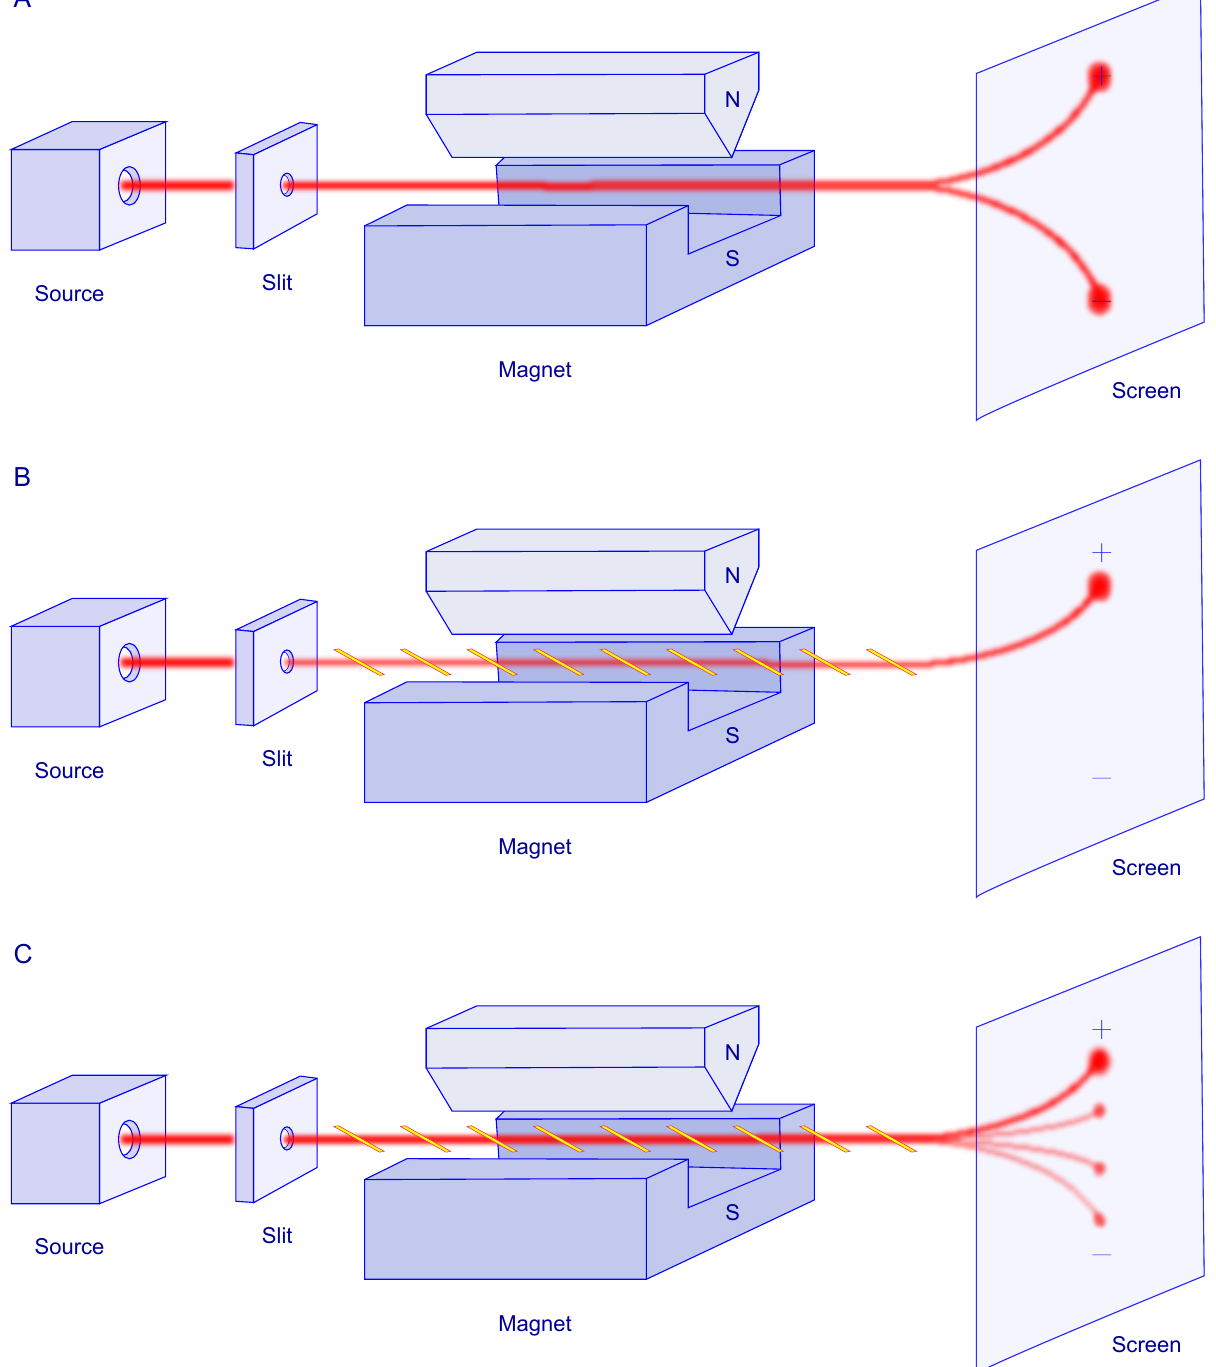
Figure 1: A. The standard Stern-Gerlach measurement setup denoting a projective measurement on a spin- 1 emits a collimated beam of silver atoms directed between the poles of a magnet that produces an inhomogeneous magnetic field. Since the silver atoms are neutral they do not experience a Lorentz force. However, silver has in its outer shell an unpaired 5 s electron that is in a zero orbital angular momentum state. Thus the deflection by the inhomogeneous magnetic field is due to the spin of the outer electron only. The top ( + ) and the bottom ( − ) spots are hit randomly with probabilities given by the initial state. B. The situation to be expected in the case of an ideal protective measurement (that is in the extreme adiabatic limit T → ∞ ). In this case, the beam hits the screen at only one spot which directly measures the expectation value of the observable in the initial state. The slashes denote the ‘protective magnetic field’ which has to be present over and above the inhomogeneous magnetic field. C. The situation in the case of the non-ideal protective measurement (that is when T is very large but finite). In this case, while the spot occurring in the ideal case has a very large probability, other cases as enumerated in subsection 5.1 occur with small but non-vanishing